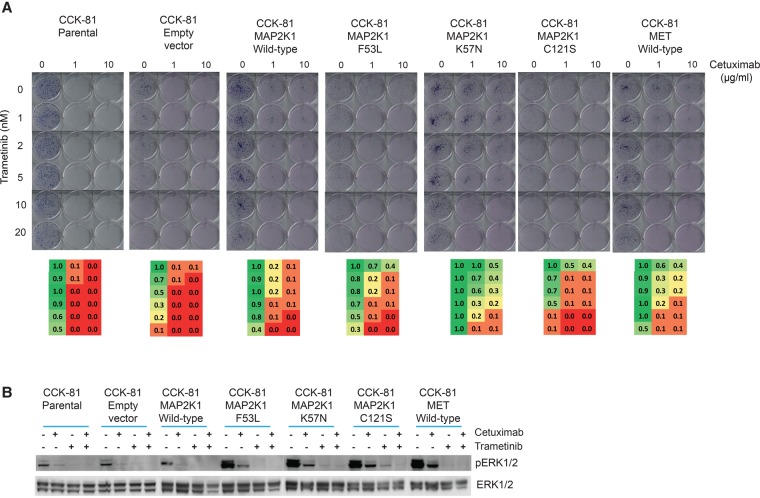
Rational targeting of resistance pathways to resensitize drug-resistant mutants. (A) Clonogenic survival assay of MAP2K1 mutant CCK-81 cells when treated with Cetuximab, Trametinib, or a combination of the two drugs. Heat maps of normalized viability effects per well are shown below each cell line. (B) Immunoblot of the effect of combing Cetuximab and Trametinib (MEK inhibitor) on MAPK signaling in MAP2K1 mutant CCK-81 cells. Cells were treated with Cetuximab (10 µg/mL), Trametinib (5 nM), or both for 6 h. MET was also overexpressed as a positive control.